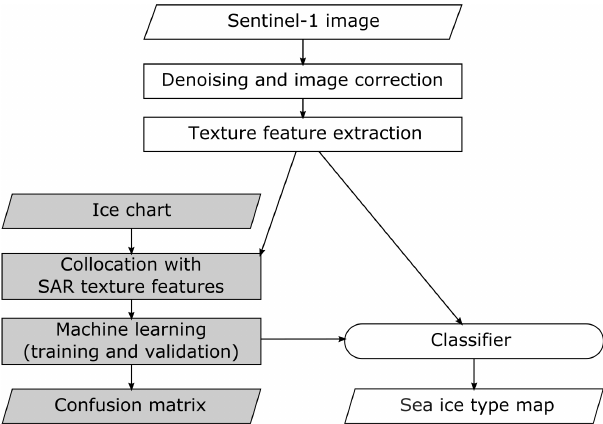
Figure 2. Processing flow chart of the proposed algorithm. The grey colour shows the training